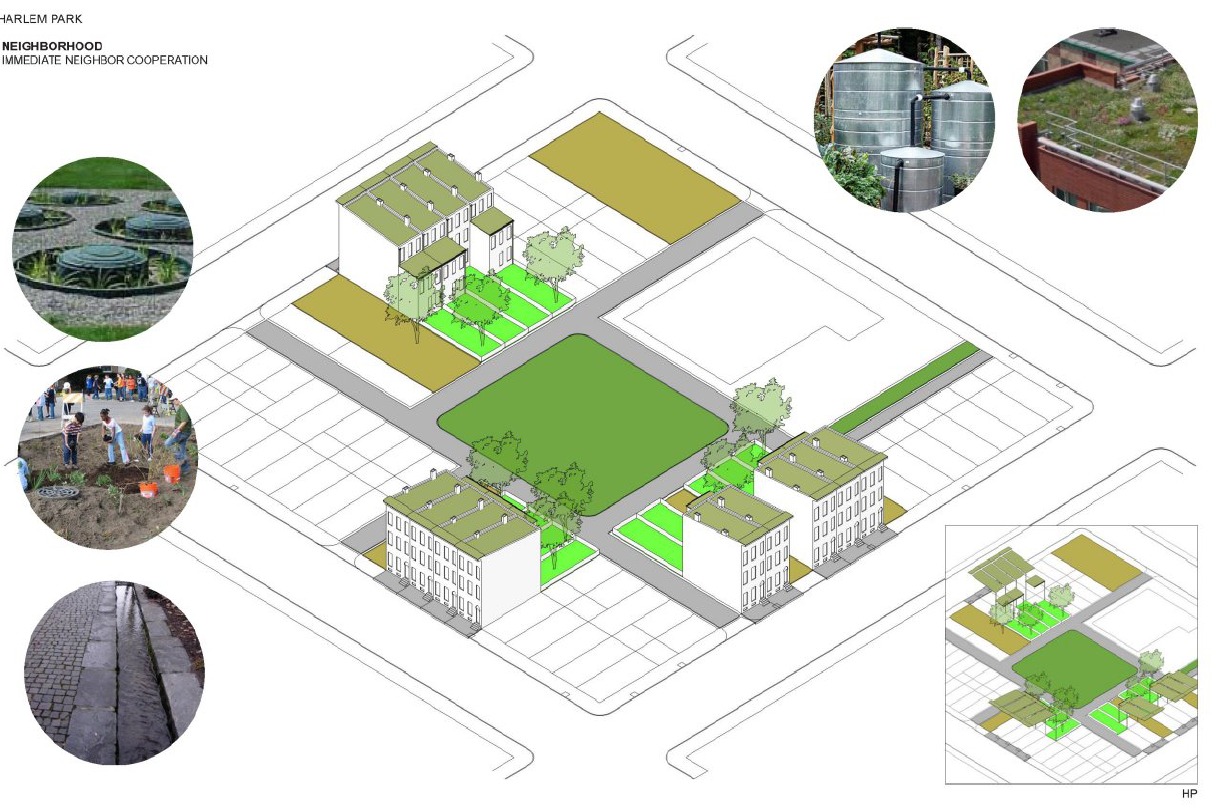
Figure 10. Water management strategies in the inner block sites of Harlem Park incorporate city parks, vacant lots and private properties. (Courtesy of